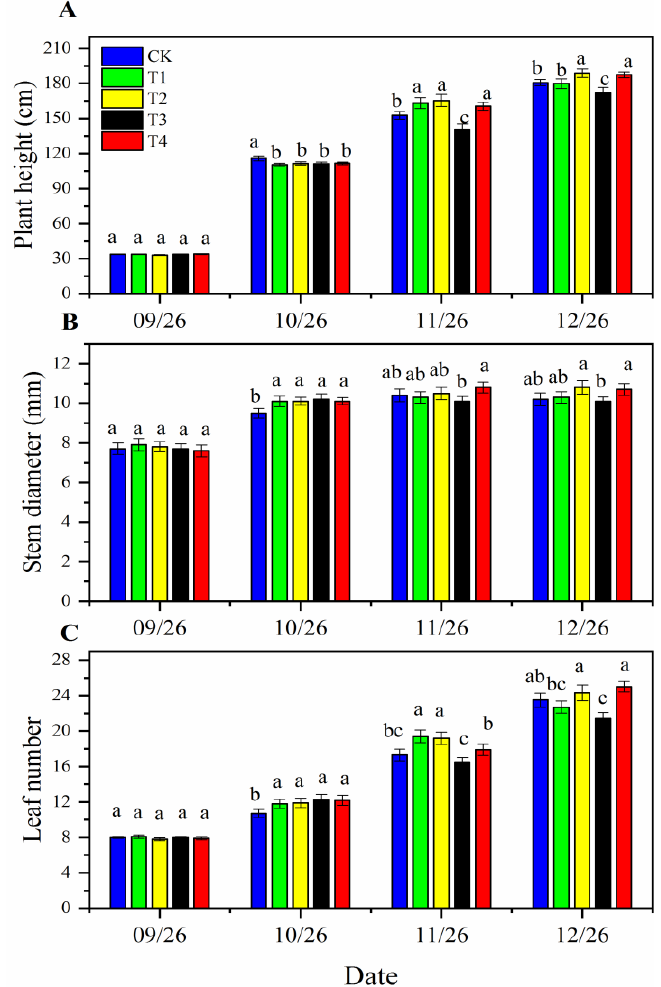
Figure 1. The growth of cherry tomato plants, supplied with different dynamic concentrations of nutrient solution. The plant height ( A ), stem diameter ( B ) and number of leaves ( C ) of tomato plants. The error bars represent the standard deviation (SD). Lowercase letters within the graph are used to compare individual mean values of the treatments, where having different letters indicates a significant differences ( p ≤ 0.05).